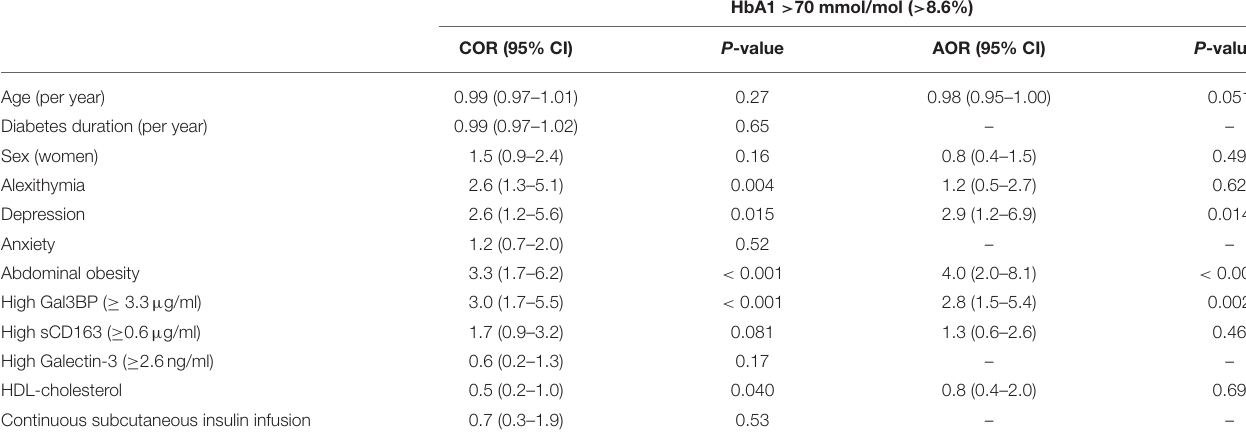
TABLE 4 | Associations with high levels of